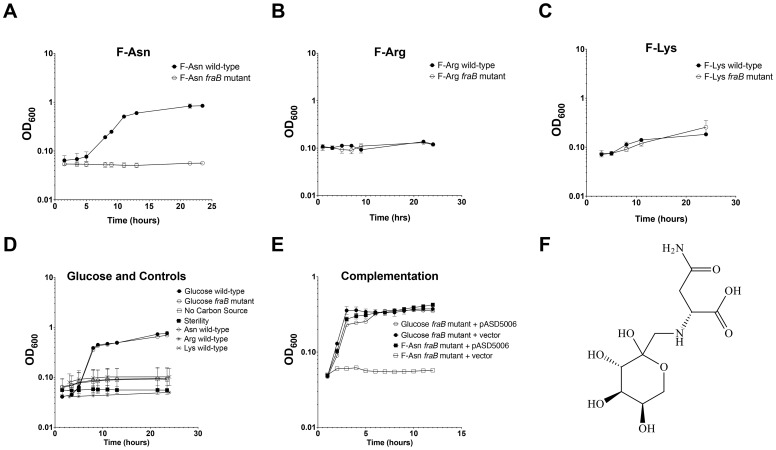
Growth of wild-type and fraB1::kan mutant Salmonella on Amadori products.Growth of wild-type MA43 and fraB1::kan mutant MA59 on F-Asn (A), F-Arg (B), F-Lys (C), asparagine, arginine, lysine, or glucose (D). Bacteria were grown overnight in LB at 37°C shaking, centrifuged, resuspended in water, and subcultured 1∶1000 into NCE medium containing the indicated carbon source at 5 mM. The optical density at 600 nm was then read at time points during growth at 37°C with shaking. Controls included NCE with no carbon source, and NCE with glucose that was not inoculated, as a sterility control (D). E) Complementation of a fraB1::kan mutation with plasmid pASD5006 encoding the fra island (ASD6000) or the vector control, pWSK29 (ASD6010). Each point in (A)–(E) represents the mean of three cultures with error bars indicating standard deviation. F) The structure of F-Asn (CAS#34393-27-6).